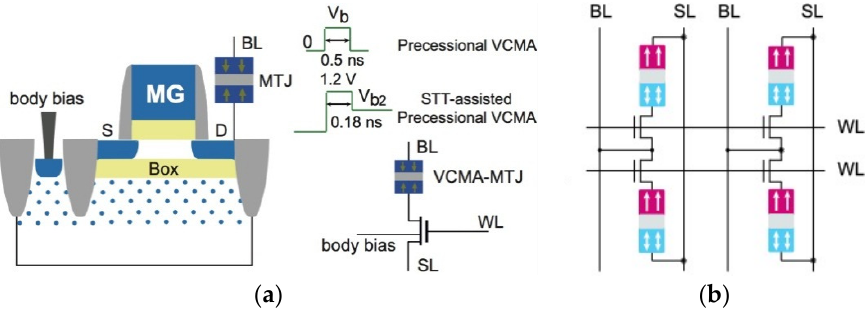
Figure 3. ( a ) VCMA ‐ MTJ based MRAM bit ‐ cell with Fully Depleted Silicon ‐ on ‐ Insulator (FD ‐ SOI) technology. Precessional switching is implemented with 0.5 ns pulse duration. STT ‐